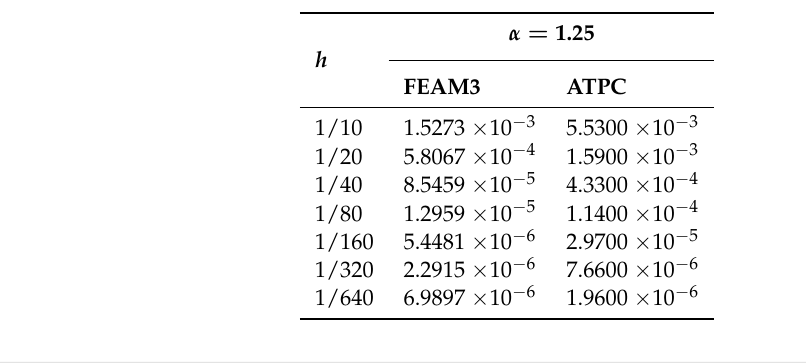
Table 7. Absolute error when α = 1.25 at different step size, h using FEAM3 and ATPC in solving Example 3.